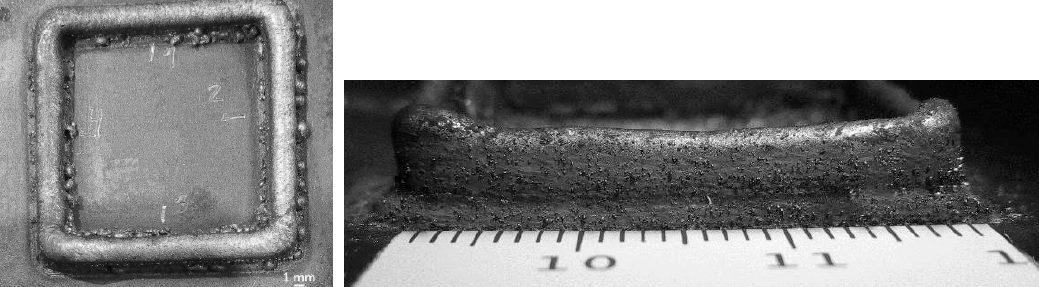
Figure 5. Picture of the contour, general view and a detail of the wall.